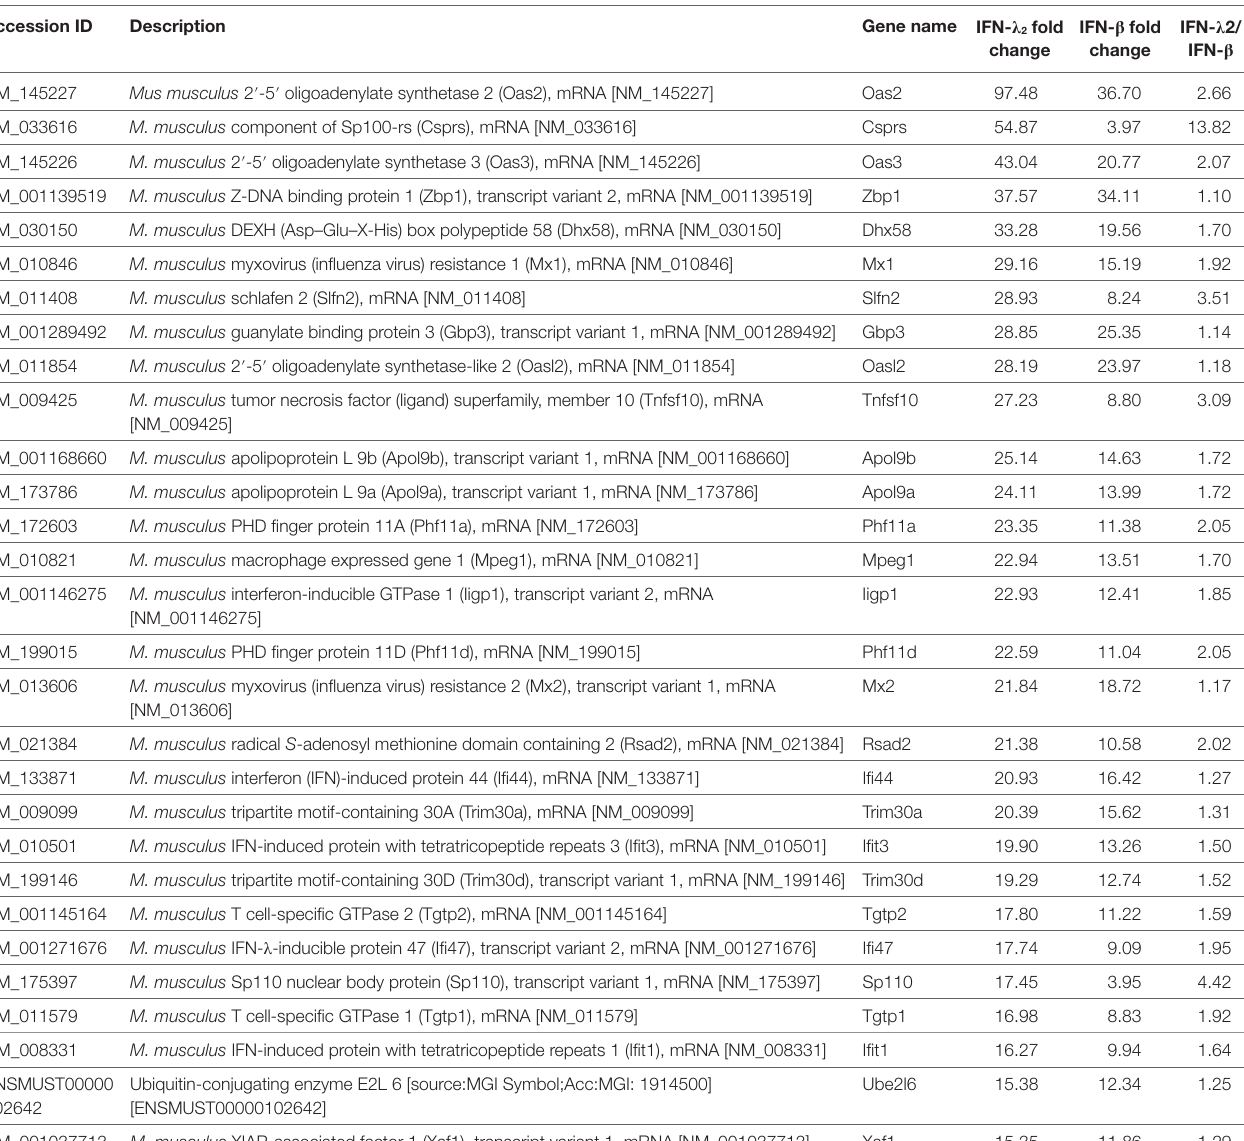
Table 1 | Top 100 genes induced by IFN- λ